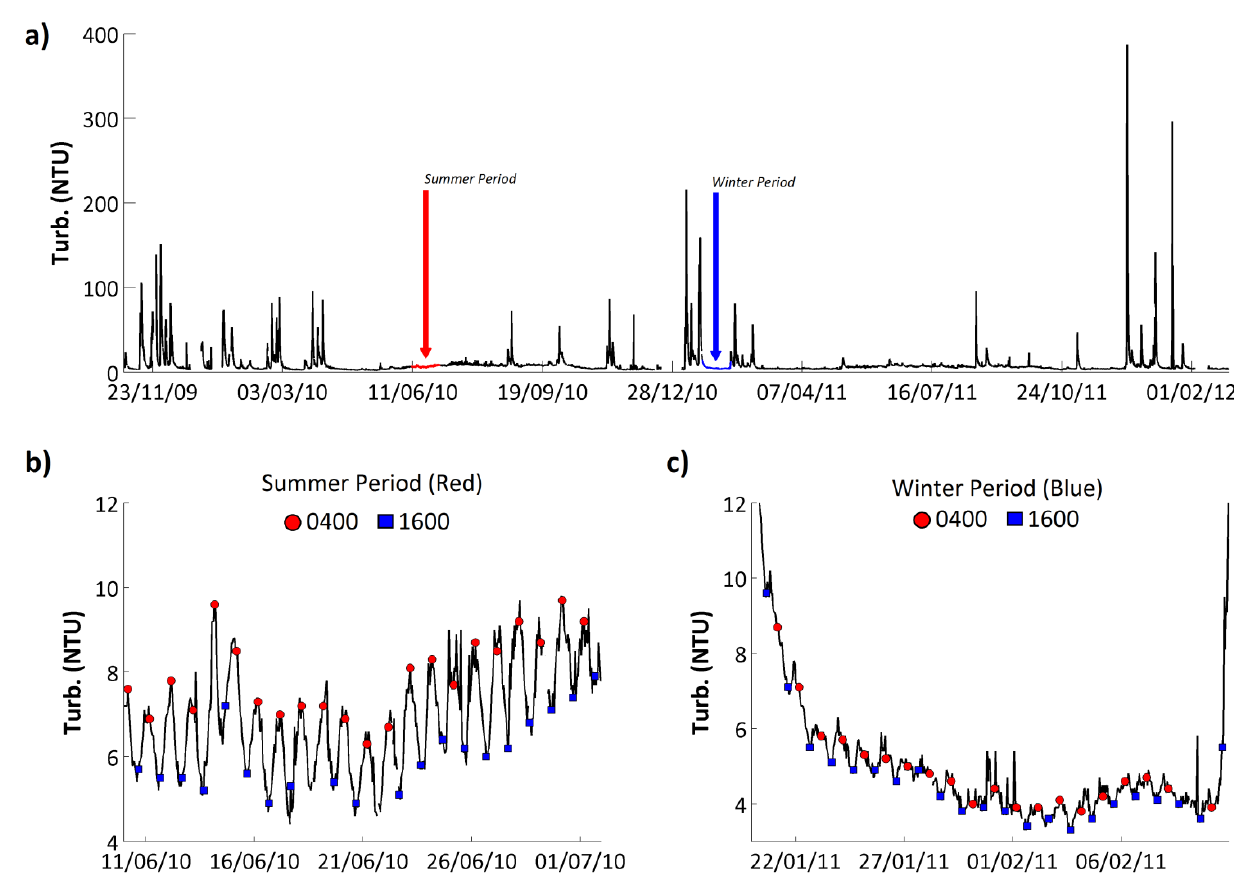
Figure 8. ( a ) Hourly turbidity record from the River Enborne at Brimpton. Two low-flow periods, one in summer ( b ) and one in winter ( c ), are highlighted and shown in expanded form, respectively. In these figures, the 0400 and 1600 GMT data points are highlighted for